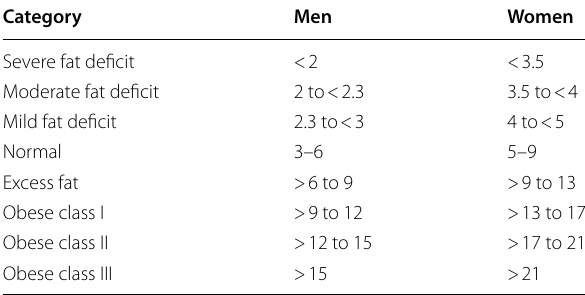
Table 3 Classification of body fat based on the fat mass index (FMI, kg/m 2 ) for men and women [10,